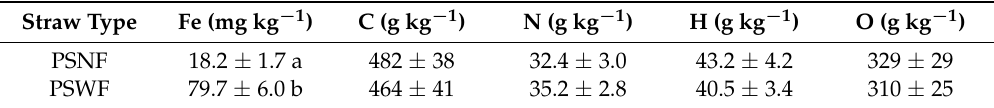
Table 1. Element contents of the peanut stalks obtained from the plot without Fe addition and the plot with Fe addition. Mean ( ± SE, n =